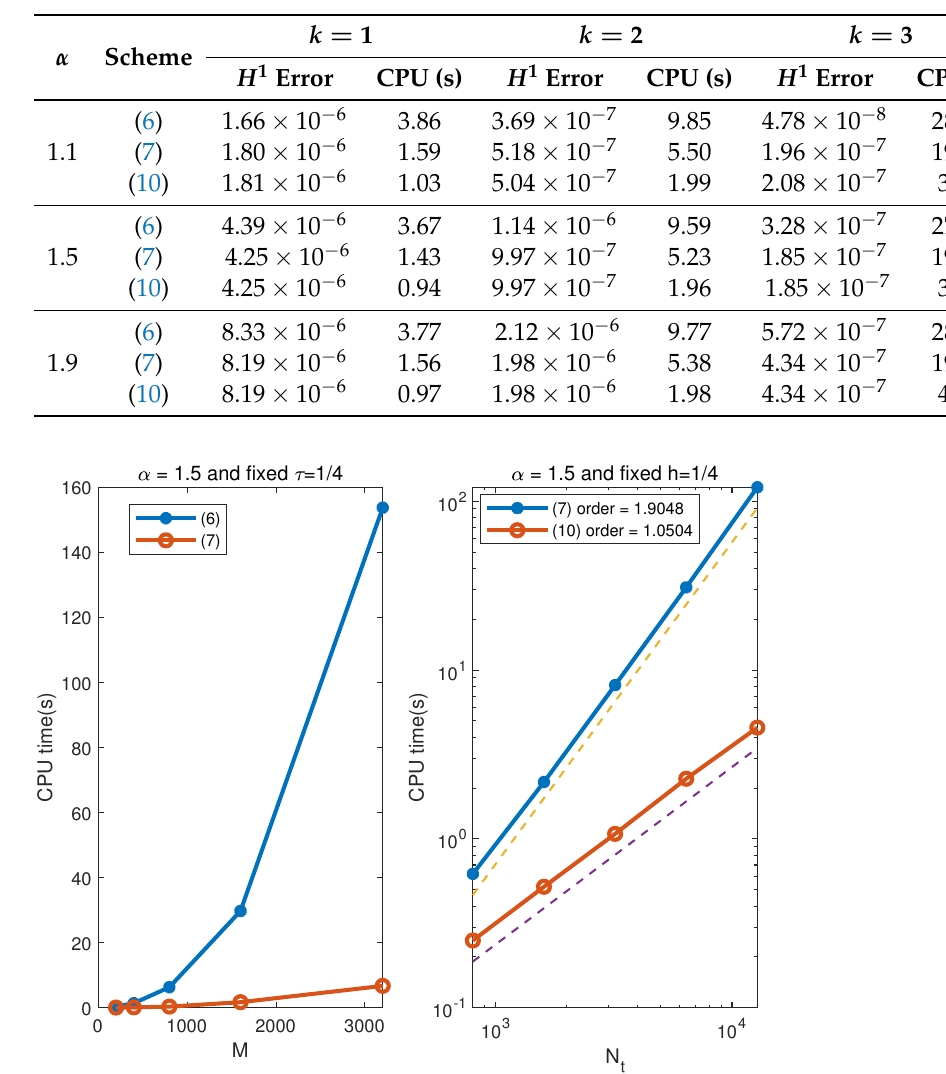
Table 5. Comparison of CPU time of three schemes (6), (7), and (10) for Example 1 with h = 1/64 and τ = 0.004/2 k .